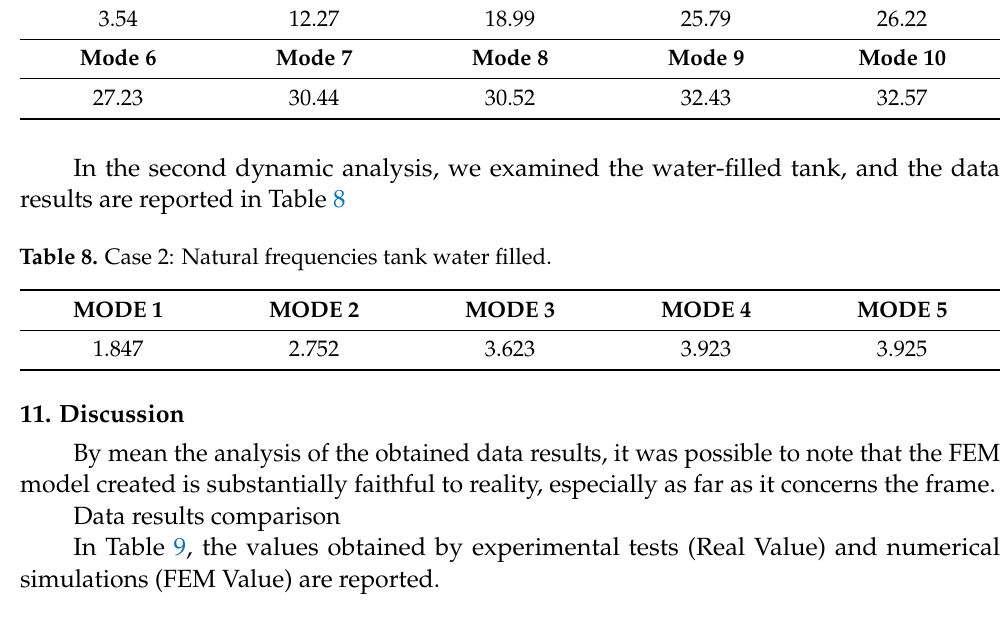
Table 9. Comparison between the results provided by the manufacturer and those resulting from the FEM